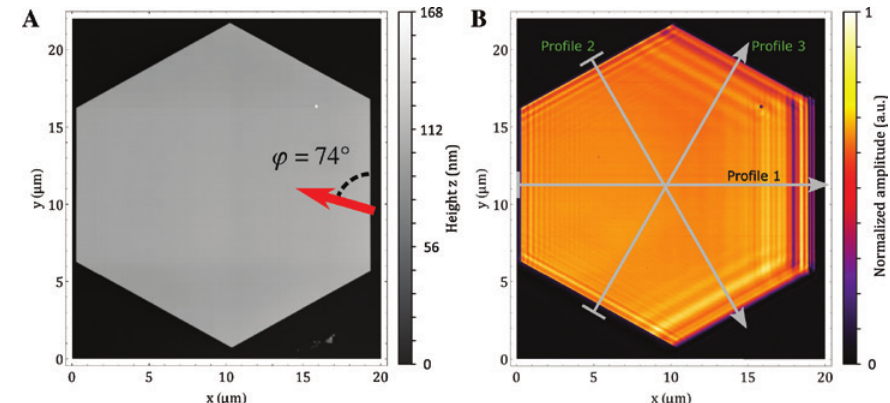
Figure 4: Topographic and near-field optical signals at an illumination wavelength of 633 nm. (A) AFM and (B) s-SNOM images of a monocrystalline gold